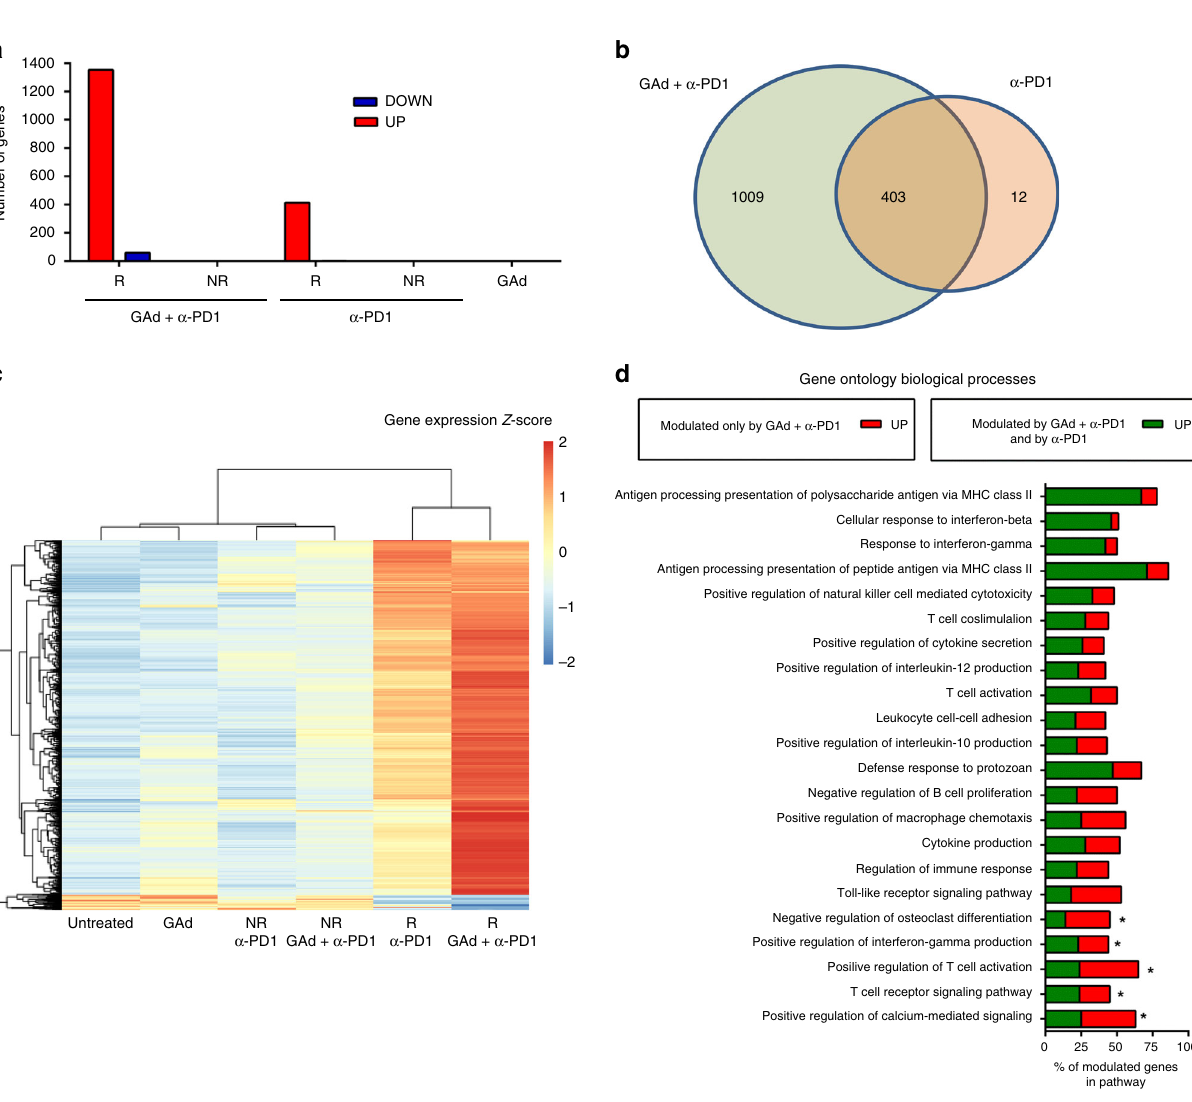
Fig. 4 Effective treatments correlate with overexpression of a large number of functionally relevant genes. a Number of differentially expressed genes (DEG) (red, upregulated; blue, downregulated) detected by RNAseq on tumors in progression (non-responders, NR) and regression (responders, R) upon anti-PD1 or anti-PD1 and vaccine combination versus untreated tumors ( n = 3 – 5/group) (median log2 FC < − 1 or >1; Benjamini – Hochberg corrected p value < 0.05). b Venn diagram showing the overlap of the DEG plotted in panel A between anti-PD1 and combination therapy. c Heat map of the 1412 DEG found in responders to the combination therapy compared to untreated for each group of treatment. d Gene Ontology (GO) enrichment analysis performed on DEG genes found in responders to GAd and anti-PD1 combination versus untreated. The 22 biological processes with at least the 40% of genes signi fi cantly modulated are shown (Bonferroni corrected p value < 0.01). Genes upregulated upon combination treatment and anti-PD1 are shown in green, those upregulated only by combination treatment are shown in red. Pathways with a signi fi cant difference in percentage of modulated genes in responders to the combo versus responders to anti-PD1 are marked with an asterisk ( p < 0.05, two-tailed, Fisher